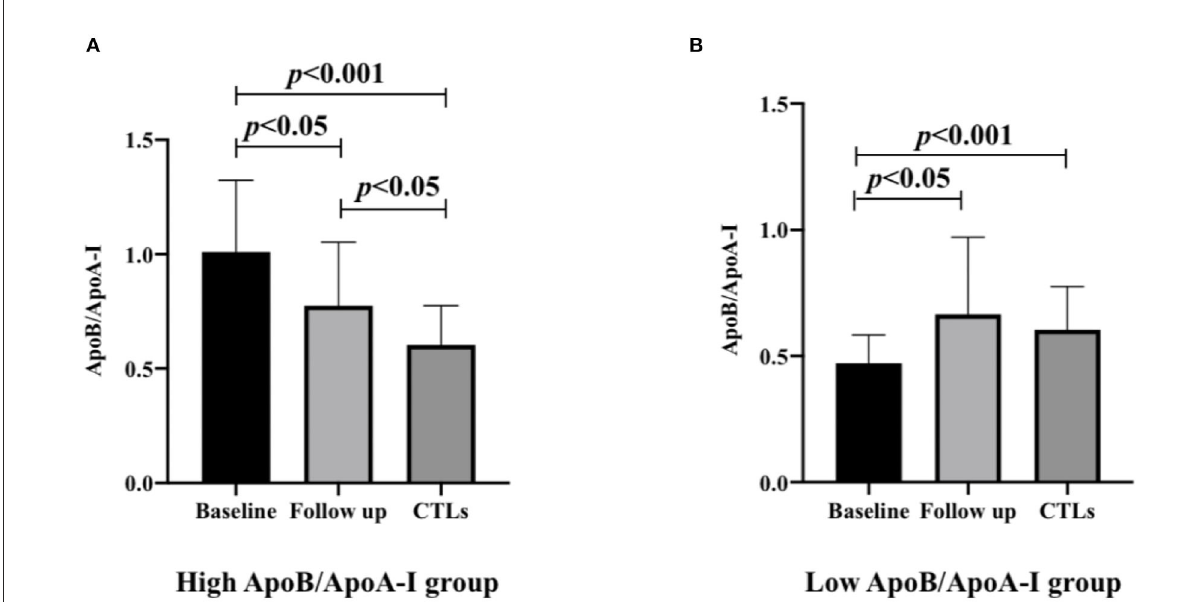
FIGURE2 The ApoB/ApoA-I ratios of high and low ApoB/ApoA-I ratio groups in patients with anti-NMDAR encephalitis are compared with CTLs ( n = 71) at baseline and follow-up. (A) High ApoB/ApoA-I ratio group in patients with anti-NMDAR encephalitis. (B) Low ApoB/ApoA-I ratio group in patients with anti-NMDAR encephalitis. A one-way analysis of variance (ANOVA) was used for multiple comparisons, followed by the least significant difference (LSD) for post-hoc test. A two-sided p -value of < 0.05 was defined as statistically significant. ApoA-I, apolipoprotein A-I; ApoB, apolipoprotein B100; anti-NMDAR, anti-N-methyl-D-aspartate receptor; CTLs,